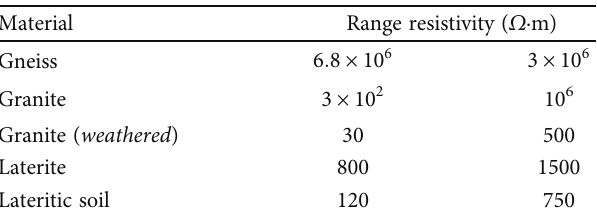
Figure 1: Revised geologic map of the northern border of the Congo Craton [17]. Table 1: Rock resistivity